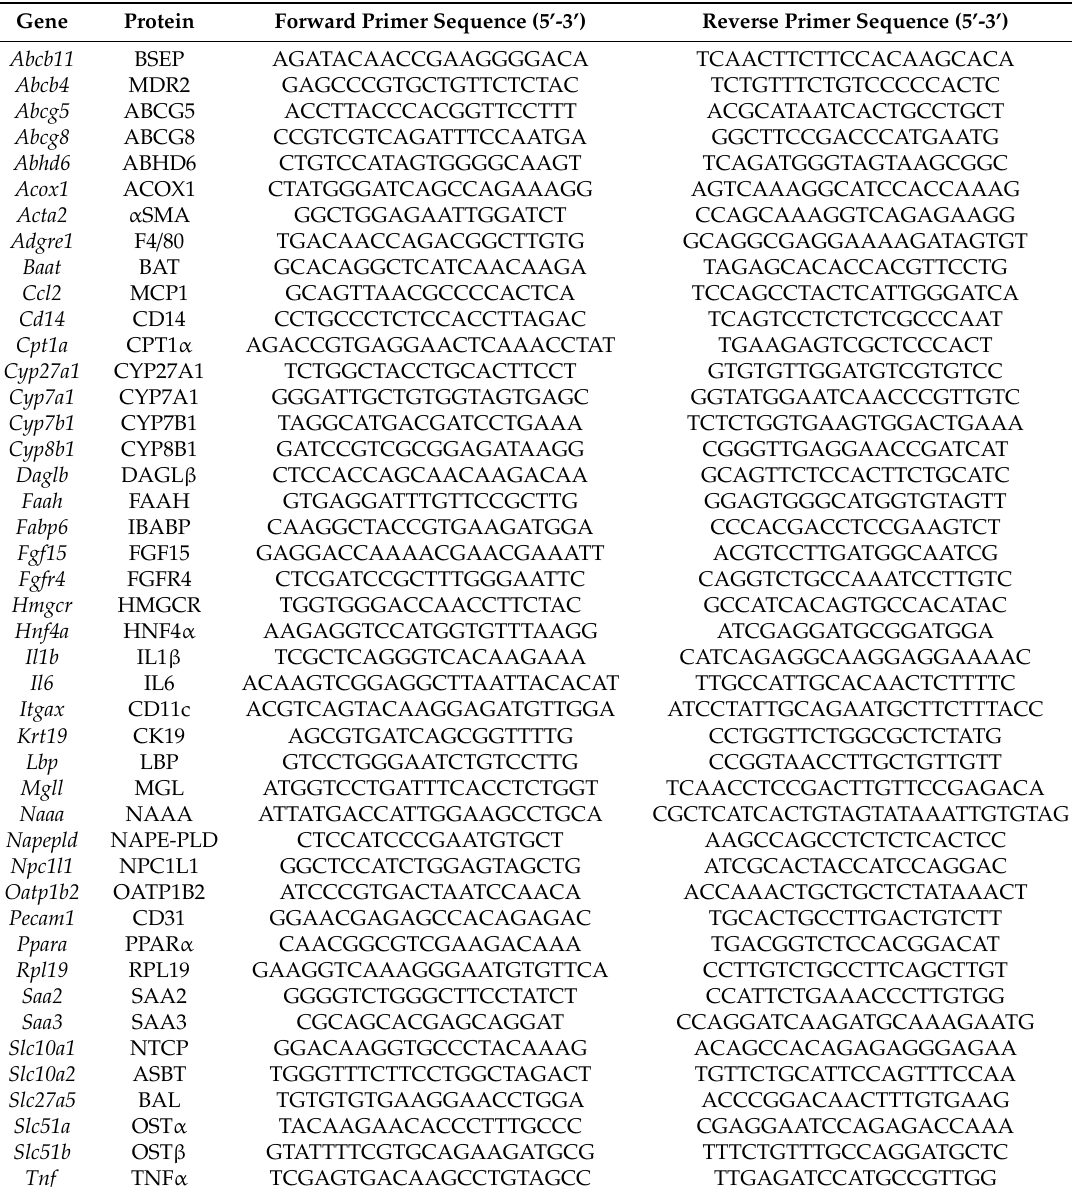
Table 1. Primers used for real-time